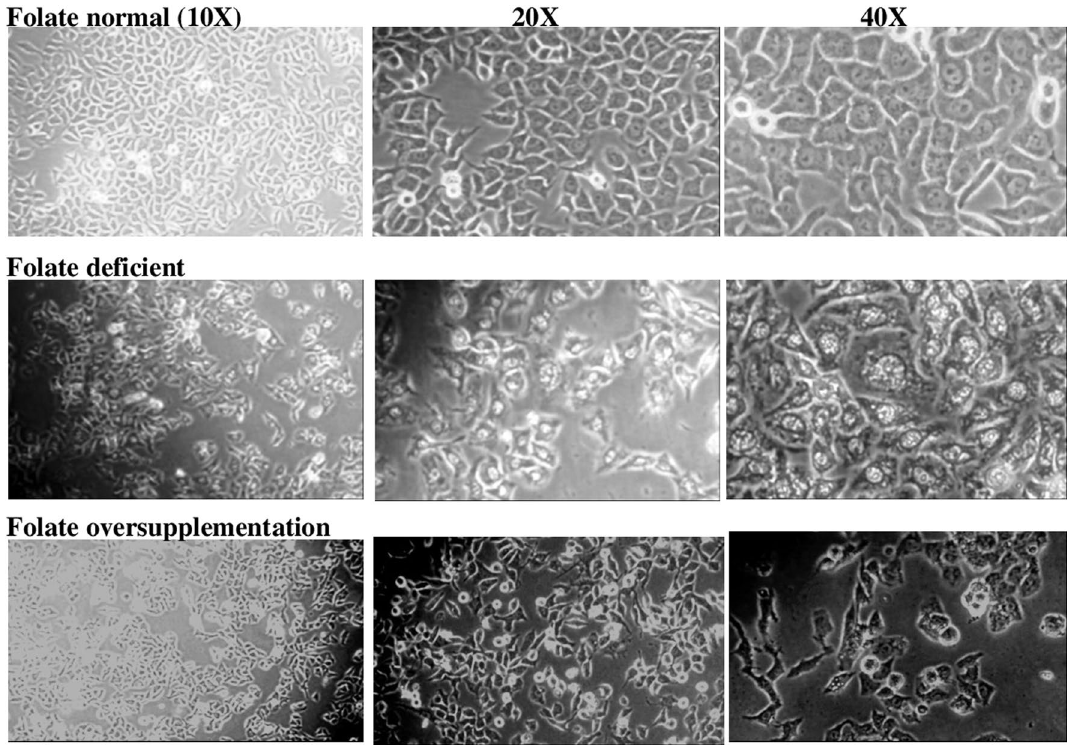
Figure 1. Effect of folic acid deficiency and oversupplementation on the morphology of HepG2 cells under the magnifications i.e. 10×, 20× and 40×. FN-Folic acid normal, FD-Folic acid deficient, FO-Folic acid oversupplemented.